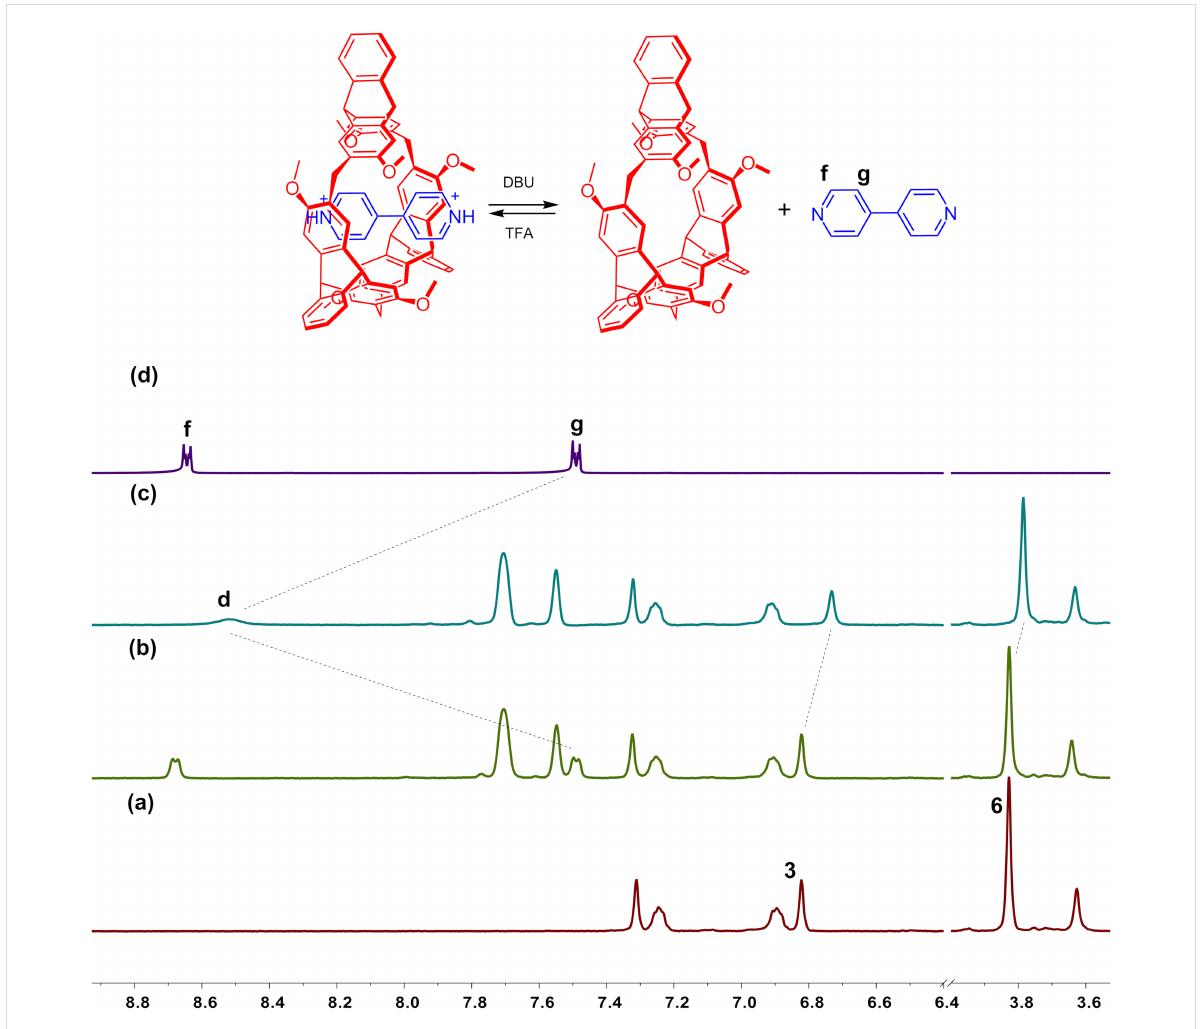
Figure 7: Schematic representation of the acid–base controlled complexation process and partial 1 H NMR spectra (300 MHz, CD 2 Cl 2 , 298 K) of (a) free H2 , (b) to the solution of complex H2·G4 were added 2.2 equiv of DBU, (c) to the solution of b were added 2.2 equiv of TFA, and (d) free 4,4'- bipyridine. [ H2 ] 0 = 2.0